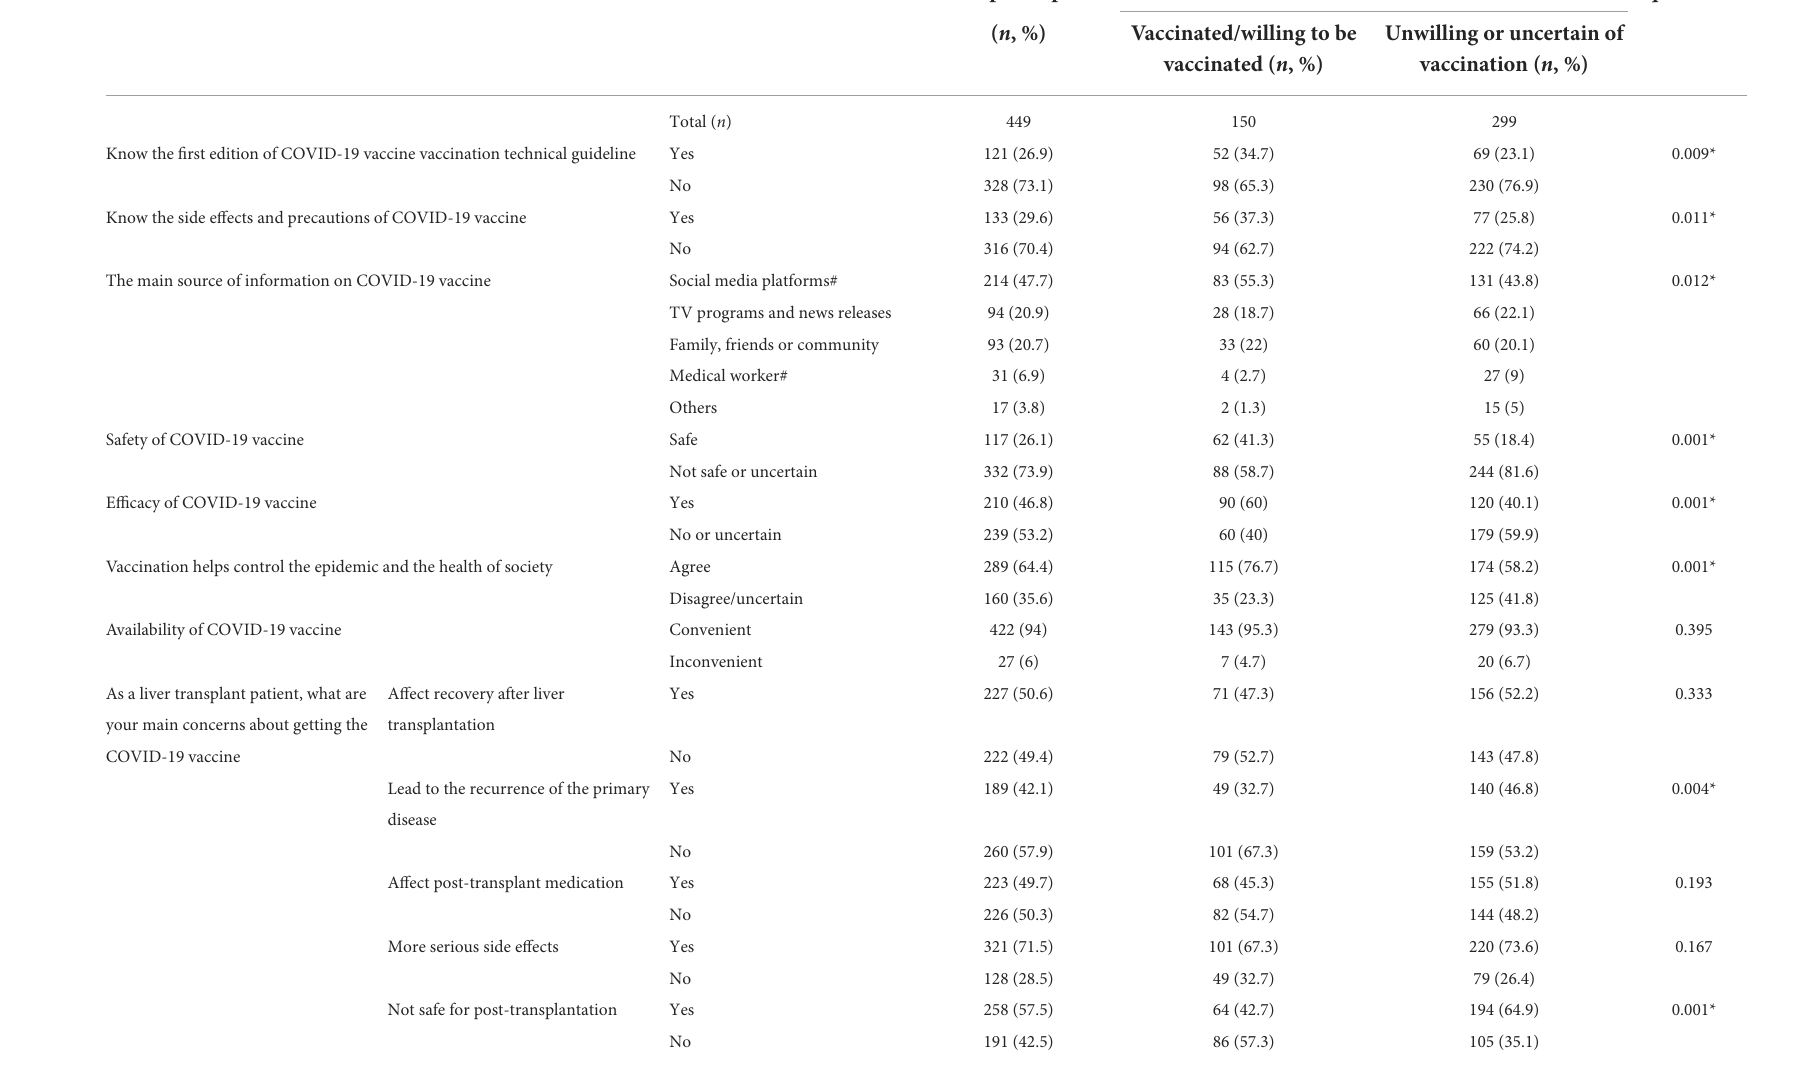
TABLE 5 Results of knowledgement about COVID-19